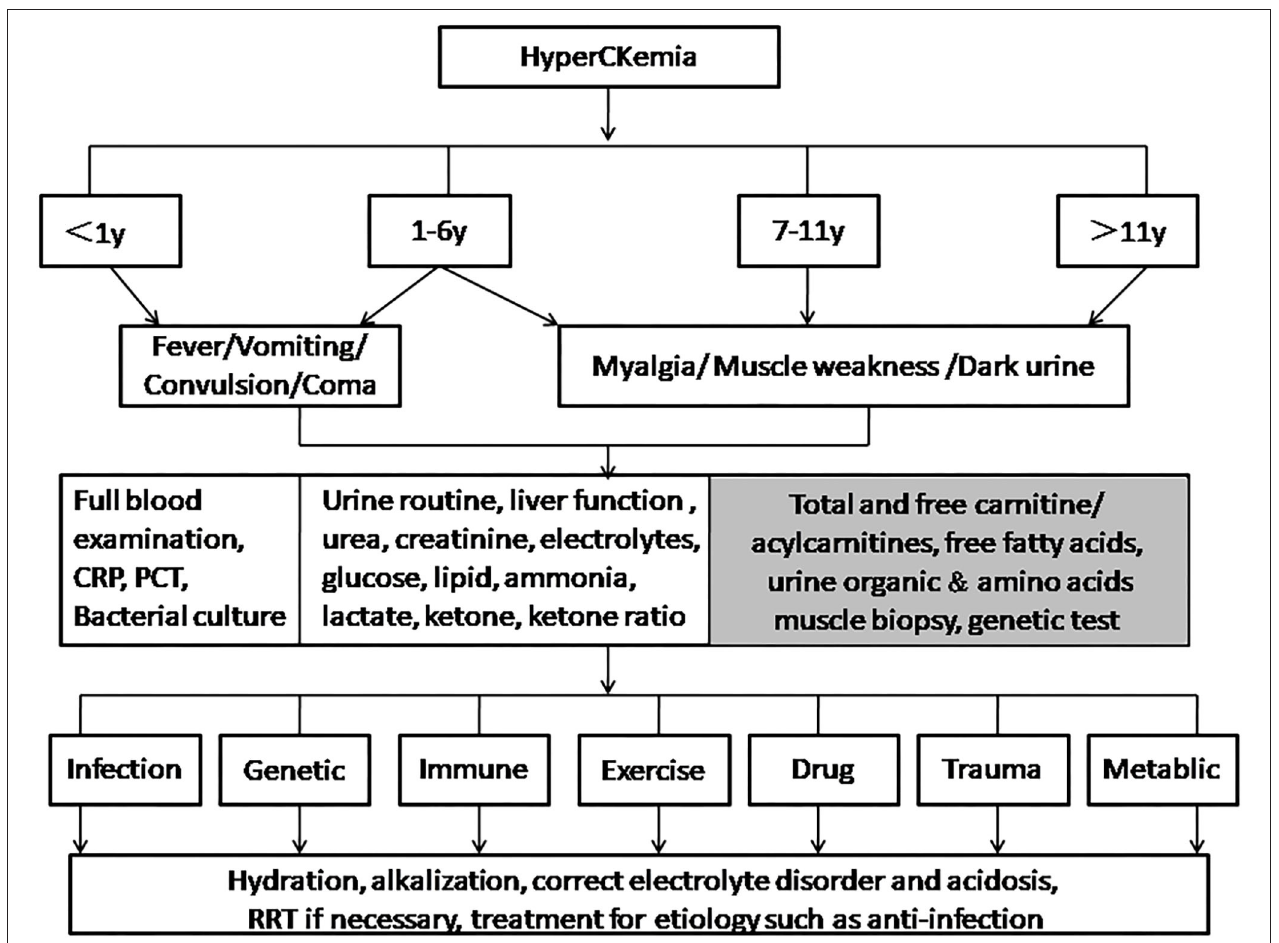
FIGURE 1 | Management of hyperCKemia in pediatric patients. For children younger than 6 years old, especially infants, it is necessary to pay attention to atypical symptoms such as fever, vomiting, convulsions, and unconsciousness. Tests such as full blood test and bacterial culture are required to determine whether there is infection causes. Children older than 6 years old are more prone to the typical triad. Tests in second box are routine. If there are abnormalities in glucose, lipids, ammonia, lactate, or ketone, items in the gray box are optionally done. Clinicians should try their best to distinguish the etiology to take appropriate treatments.